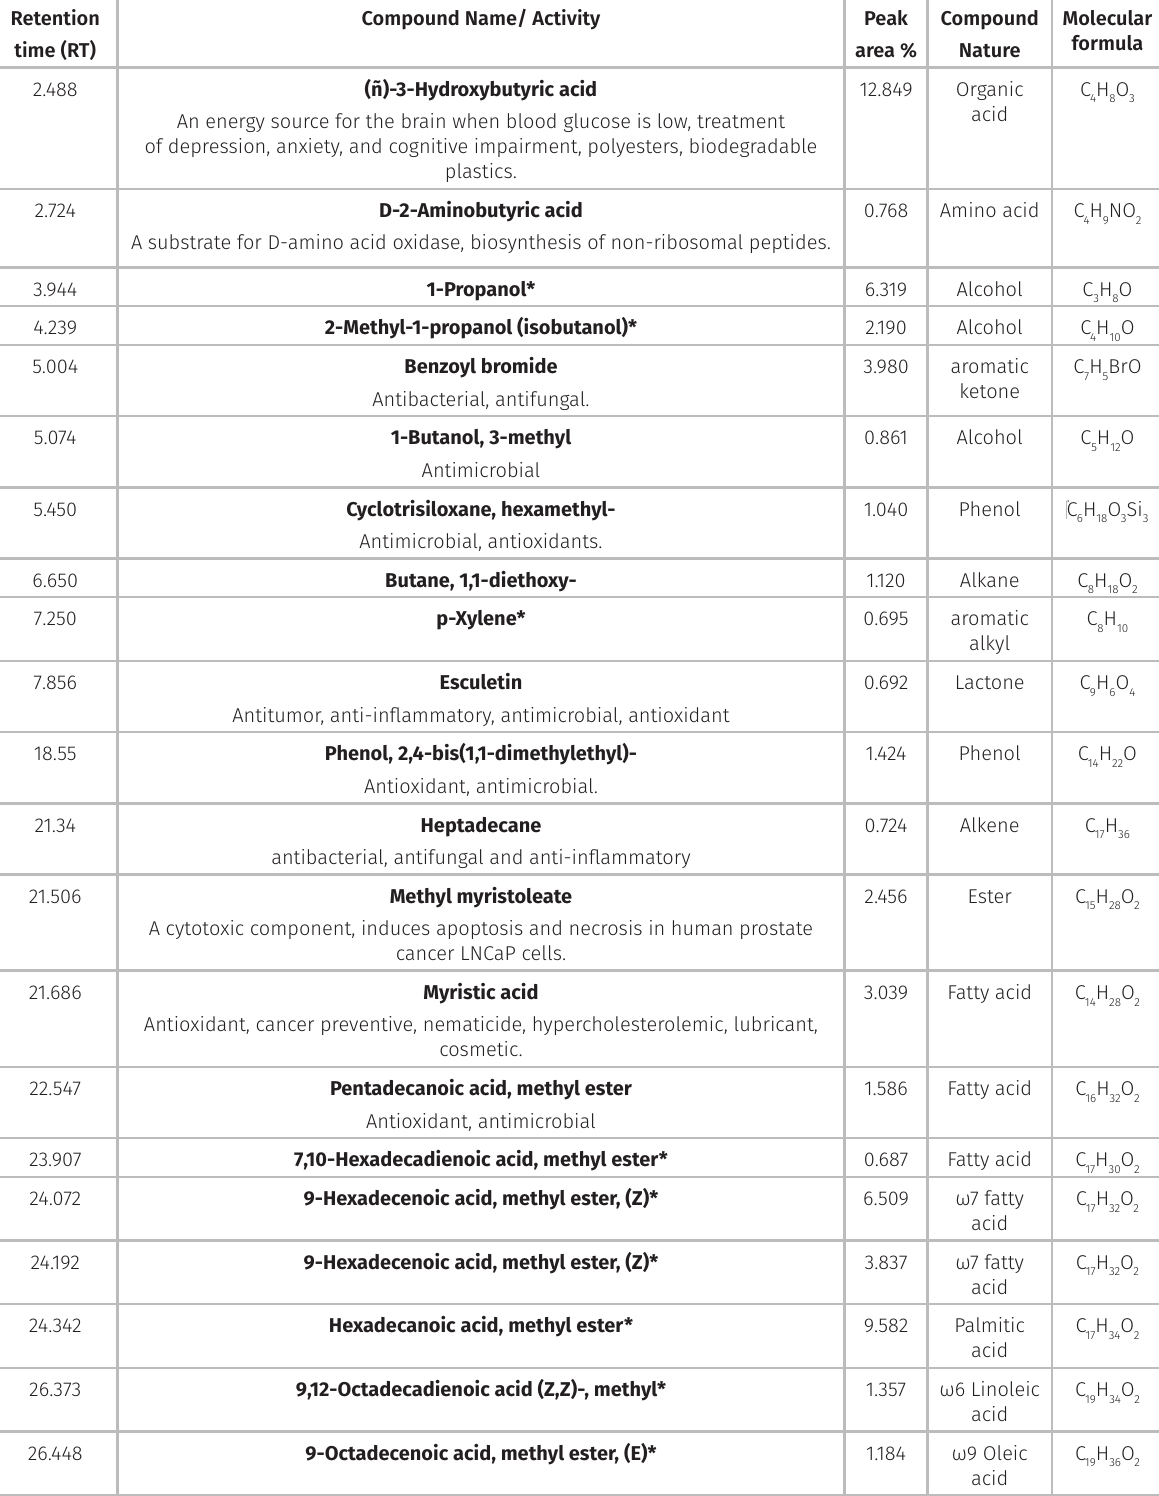
Table VIII. GC-MS analysis of Oscilatoria amphigranulata in methanolic extract**.